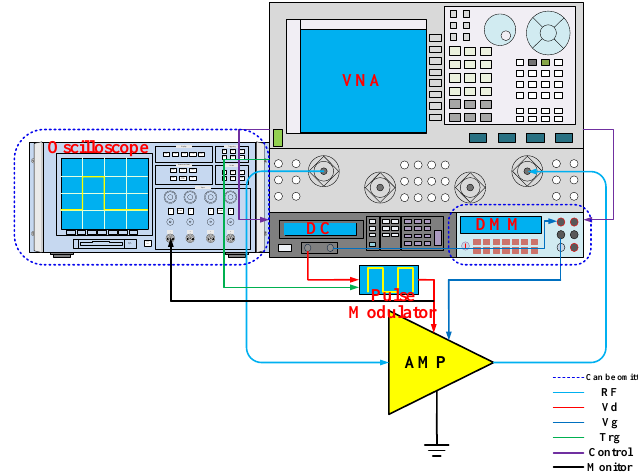
Figure 15. The new all-in-one solution.